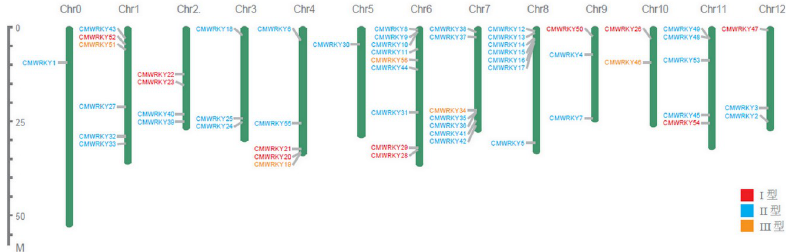
Fig 2. Chromosomal location of WRKY family genes in melon. The size of a chromosome is indicated by its relative length. The chromosome numbers were shown at the top of each